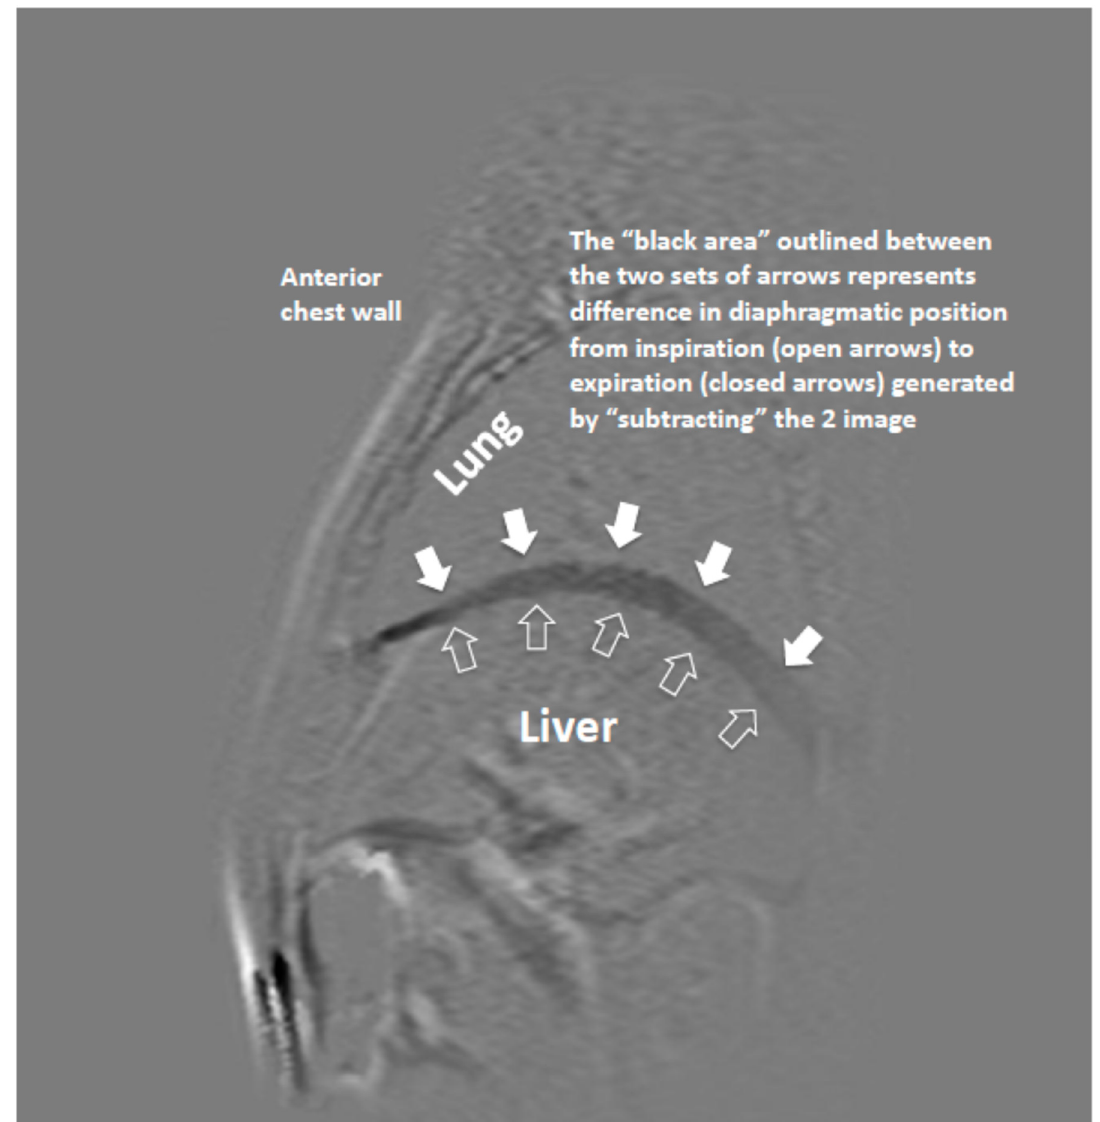
Figure 1. Magnetic resonance (MR) Image of hemi-diaphragm (sagittal view) showing subtraction of maximal and minimal positions of hemi-diaphragm n two sequences.